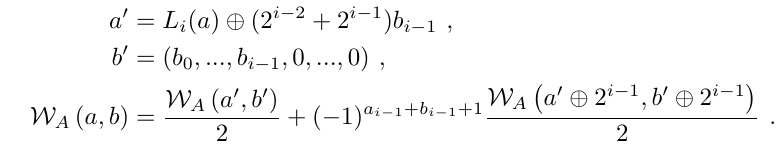
be a linear function. The Walsh coefficient W A ( a, b ) = P to 0 if a < 2 i or a ≥ 2 i +1 . Otherwise, it can be deduced from values of W A ( ., . ) for